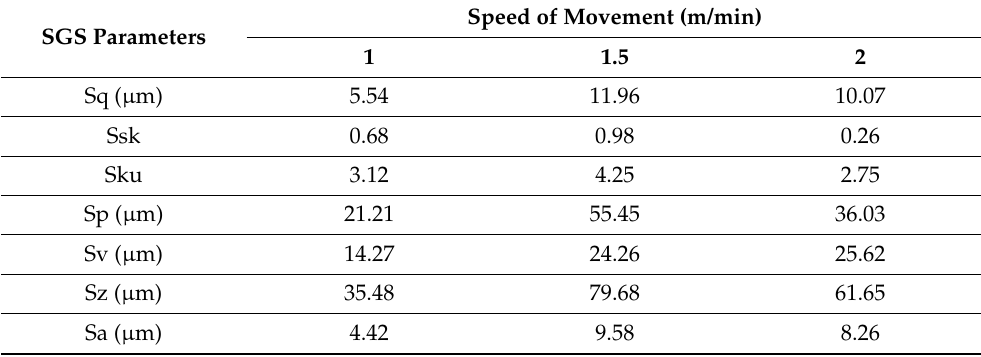
Table 10. Parameters of the SGS after laser alloying (sample 2).